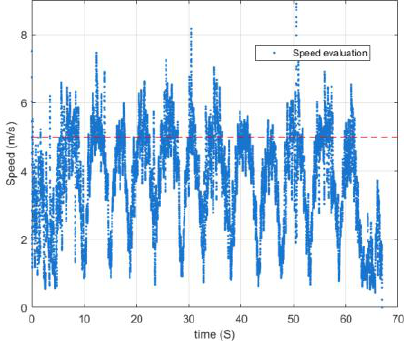
Figure 9. Motion speed.